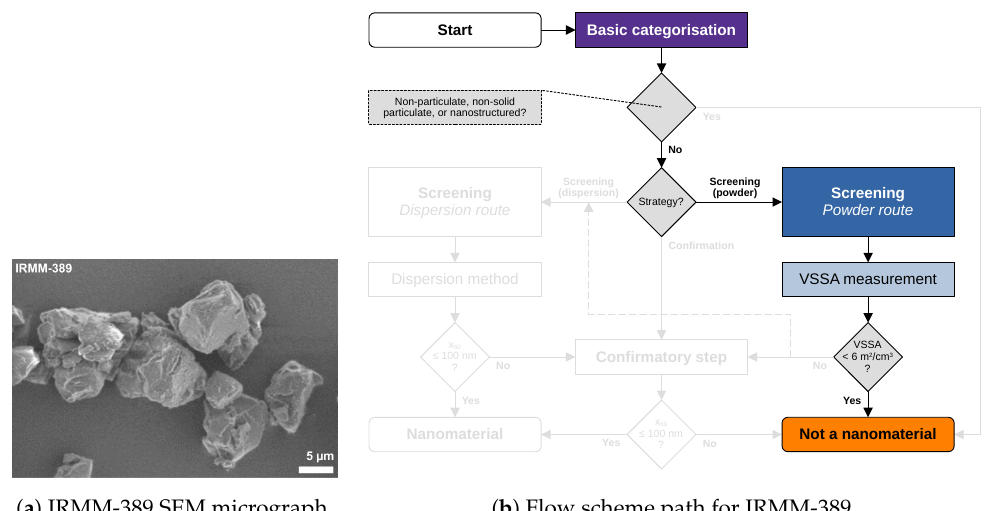
Figure 2. IRMM-389 (basic methacrylate copolymer): ( a ) representative SEM micrograph, and ( b ) re- spective flow scheme path. The tier 1 method BET yielding a VSSA = 1 m 2 /cm 3 directly leads to a “not a nanomaterial” categorisation.